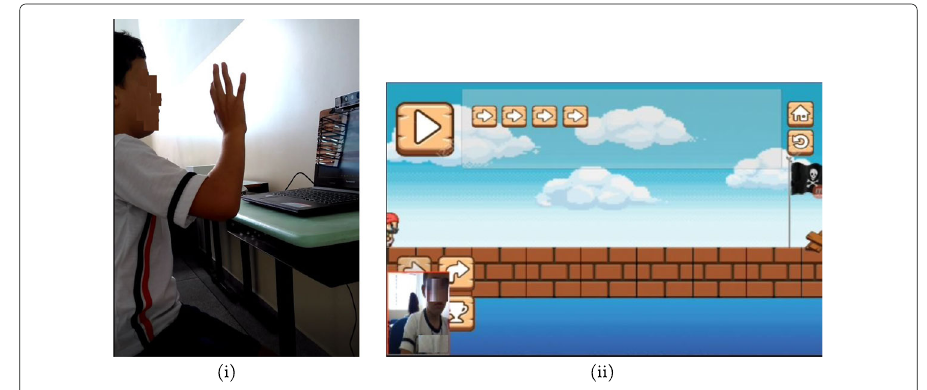
Fig. 2 Children interacting with the game versions. i Camera version. ii Tablet